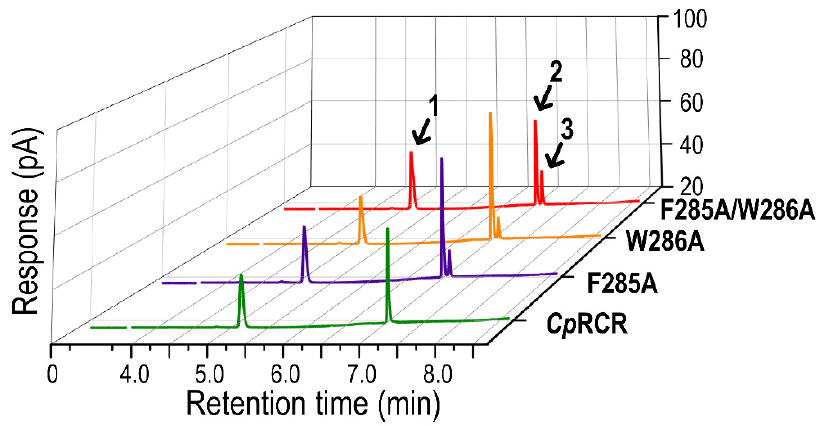
Figure 6. The GC traces of the wild type Cp RCR and variants F285A, W286A, and F285A/W286A- catalzyed DHF reduction. Compounds 1 – 3 correspond to DHF , ( S )-DHF-ol , and ( R )-DHF-ol , re-